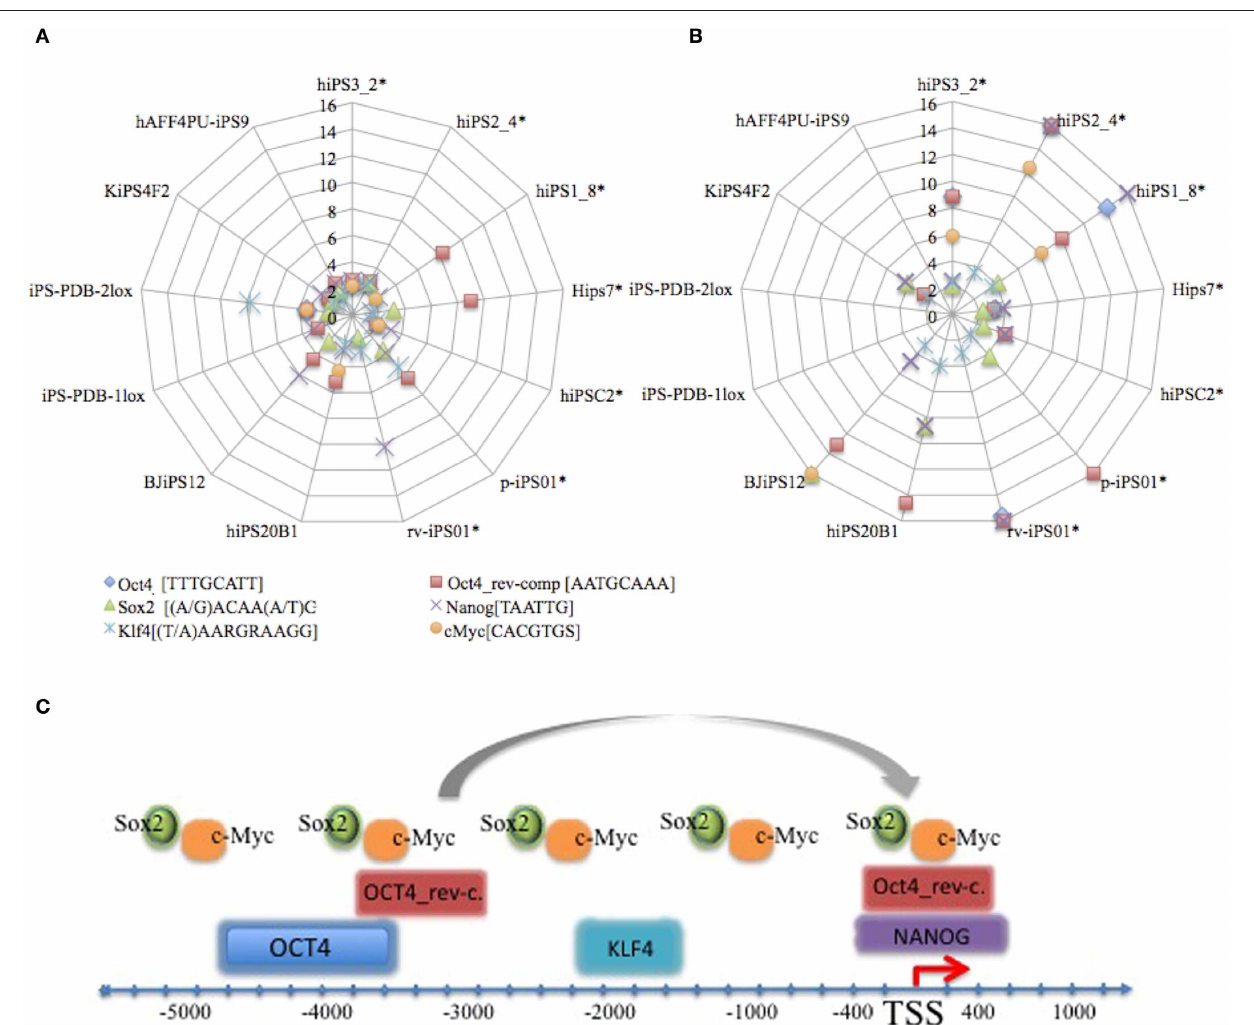
FIGURE 2 | Distribution of predicted binding motifs over-representation score in the promoters of up- (A) and down-(B) regulated genes comprising “master” and “master_development” groups in 13 cell lines used in our study. Asterisks (*) reference neonate cell lines. Symbols on the graphs correspond to the values represent over-representation score of the motif in the respective cell line (control) comparing to the random set of housekeeping genes (background)